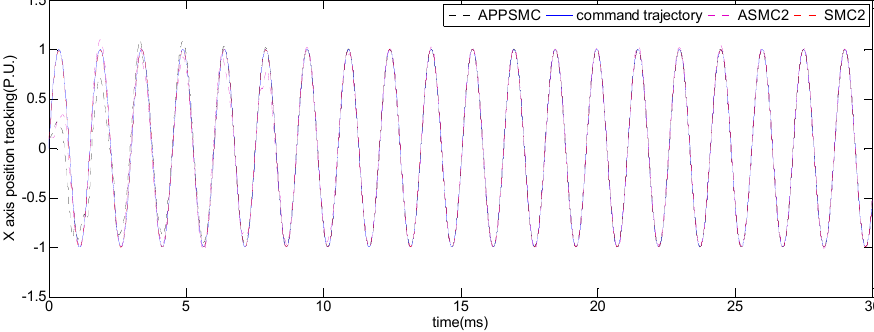
Figure 8. X axis trajectory tracking comparisons of SMC2, ASMC2, and APPSMC.